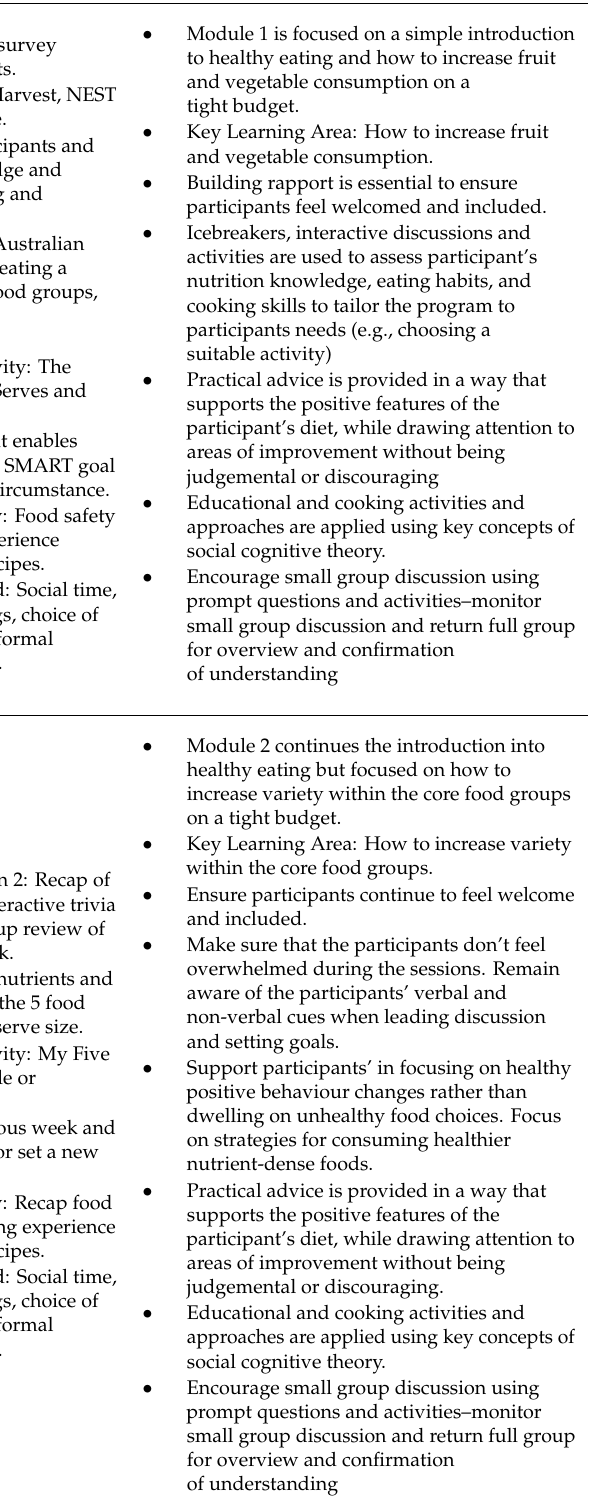
Table 1. NEST (Nutrition Education and Skills Training) Program Session Details. Session Lesson Outline Teaching